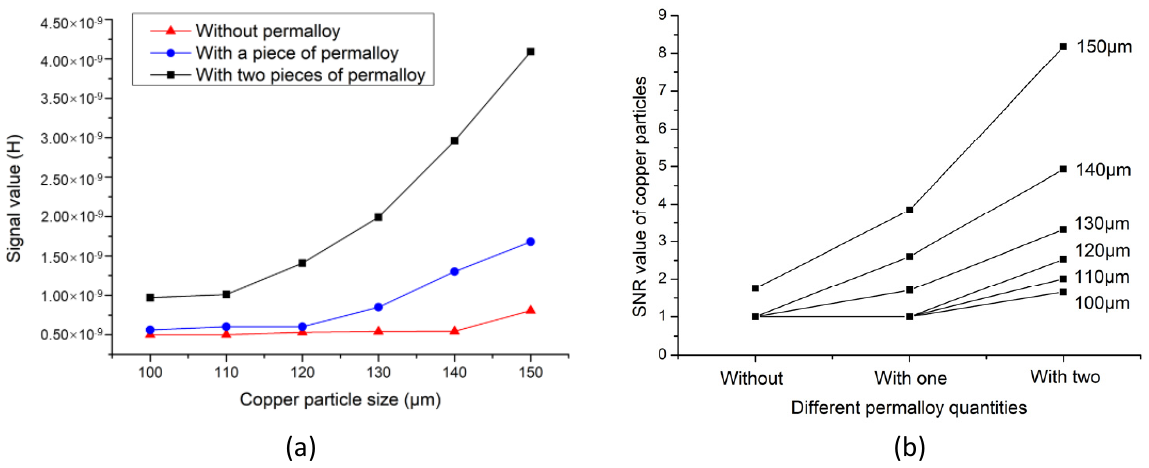
Figure 12. Copper particle detection results. ( a ) Average signal value of copper particles; ( b ) Average SNR value of copper particles.